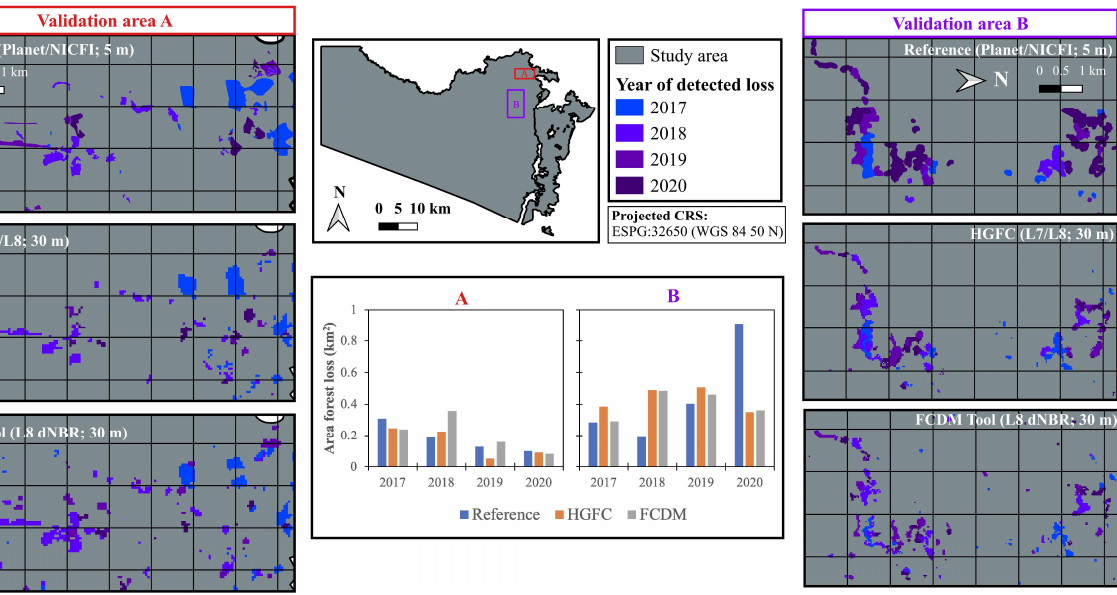
Figure 3. Validation of the Hansen Global Forest Change (HGFC; v1.9) product for the years 2017– 2020 over two sample regions ( A , B ) in northeastern KNP using (1) high-resolution Planet/NICFI satellite imagery (Reference dataset) and (2) the Forest Canopy Disturbance Monitoring Tool (FCDM Tool) developed by